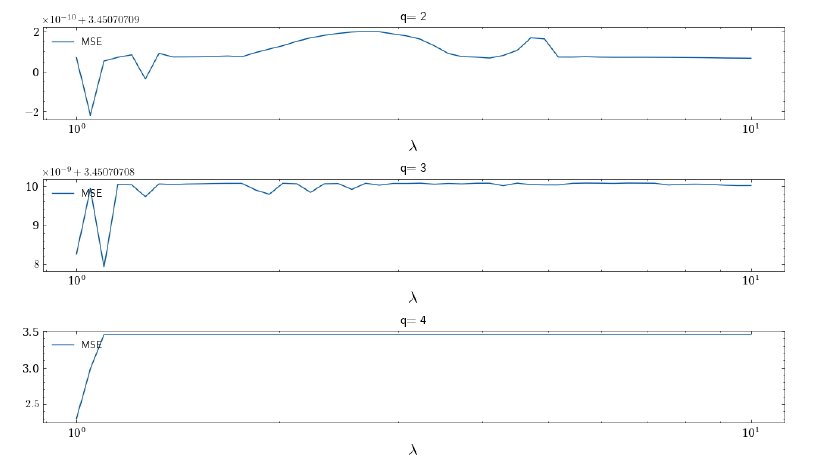
Figure 1. MSE with respect to λ for different values of q .